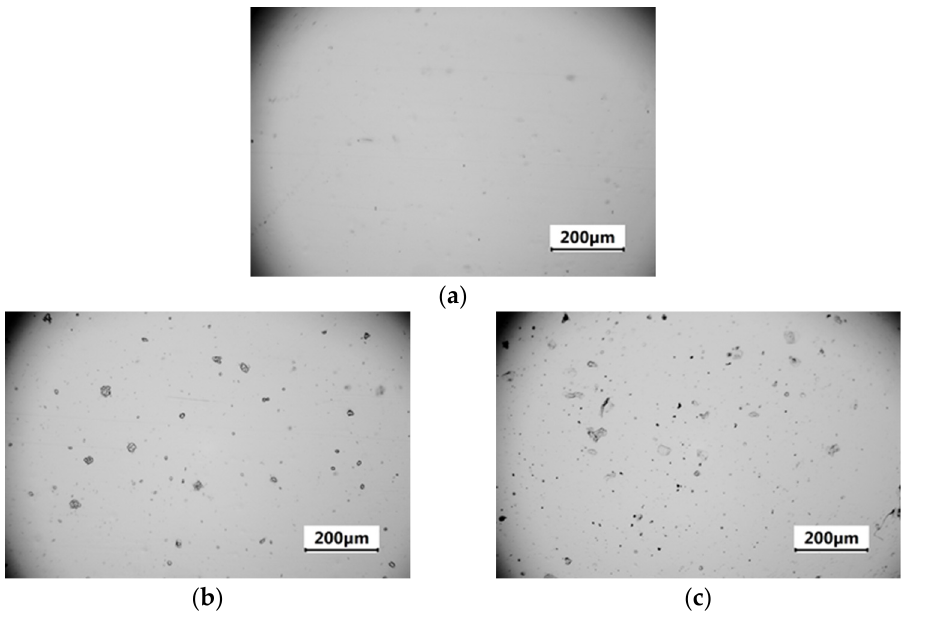
Figure 9. Micrographs of PLA samples before and after incubation in aqueous environments with sodium azide: ( a ) before degradation; ( b ) 12 months in pond water; ( c ) 16 months in seawater. Source: Own research.